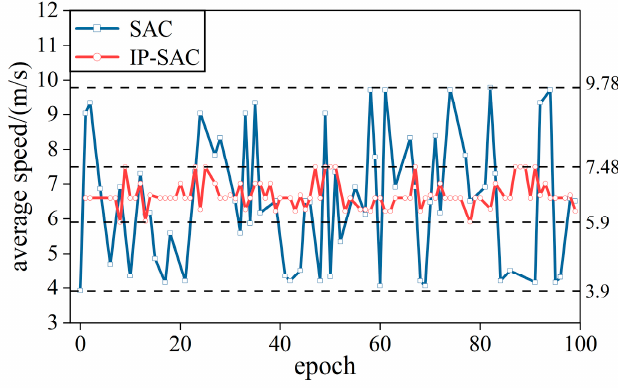
Figure 9. The average speed of SAC and IP-SAC policies.